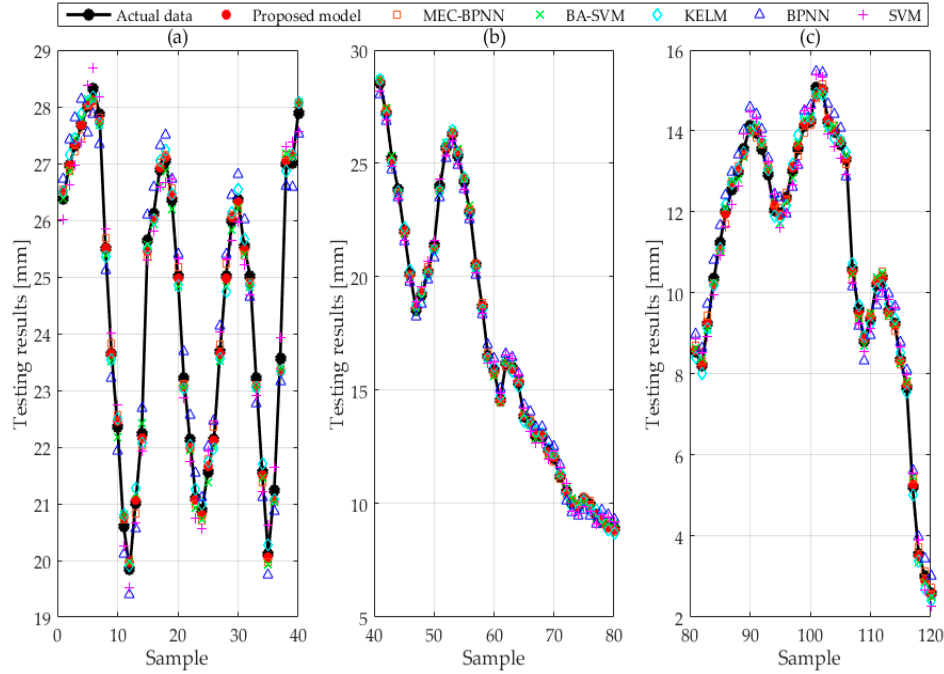
Figure 8. The forecasting values of different methods: ( a ) the forecasting value from 1 to 40 sample point; ( b ) the forecasting value from 41 to 80 sample point; ( c ) the forecasting value from 81 to 120 sample point.